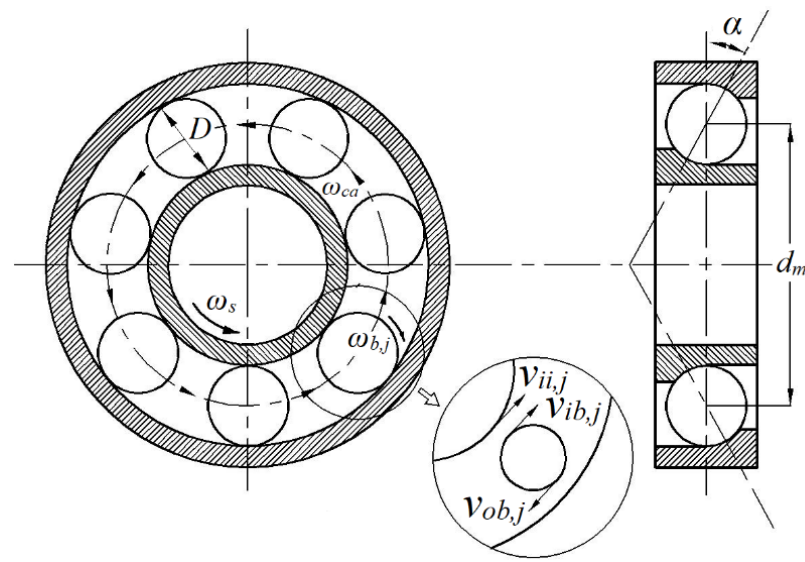
Figure 2. Kinematical relationship for a ball bearing.